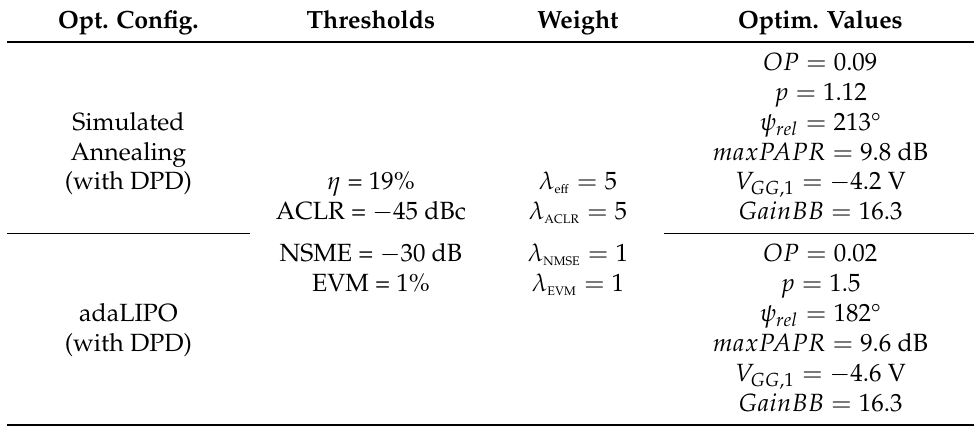
Table 3. Parameters configuration for the CA-4 × LTE-20 200 MHz bandwidth